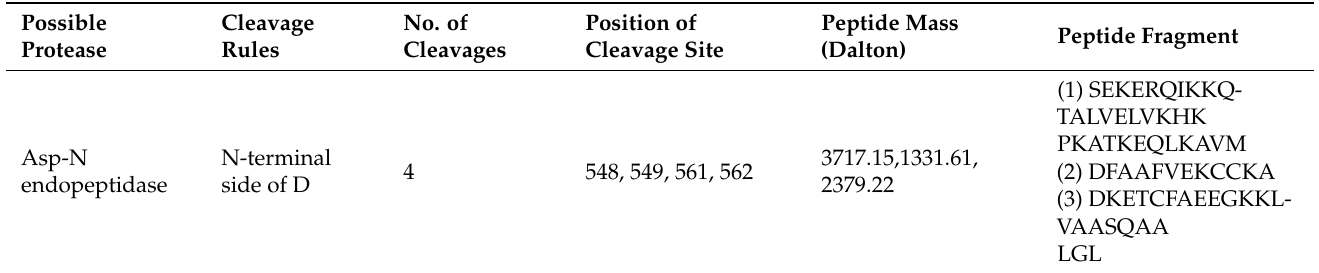
Table 2. The potential protease cleavage fragments of HSA subdomain IIIB.